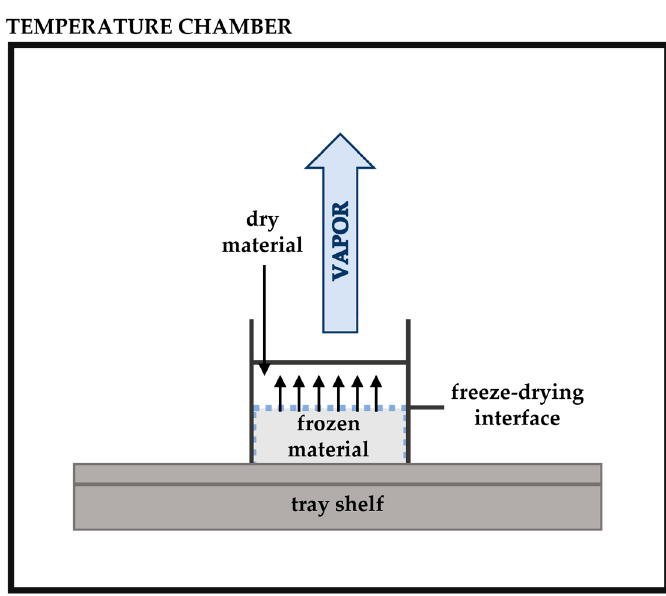
Figure 13. Schematic diagram of a freeze dryer (adapted from [163]).